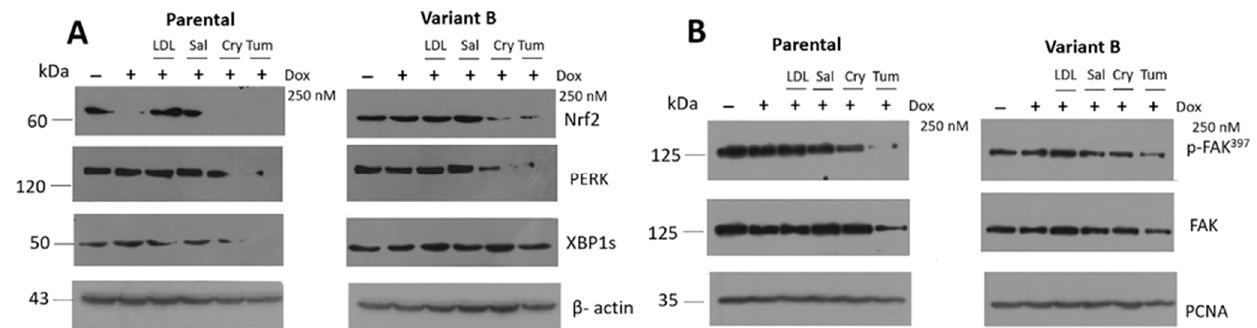
Figure 5. Doxorubicin (Dox) chemoresistance is associated with PERK/Nrf2 activation and regulated by cryptotanshinone (Cry). ( A ) Expression of Nrf2 under the Dox treatment (250 nM) and concomitant LDL (10 µ g/mL), Sal (25 µ M), Cry (25 µ M), and Tum (1 µ g/mL) in parental and variant B cells. In this experiment, XBPIs role was confirmed in variant B. β -actin was used as a loading control. ( B ) Under the same conditions, characterization of FAK pathway, evaluated by the expression of FAK and its phosphorylation at Tyr-397 (p-FAK 397 ). PCNA was used as a loading control.